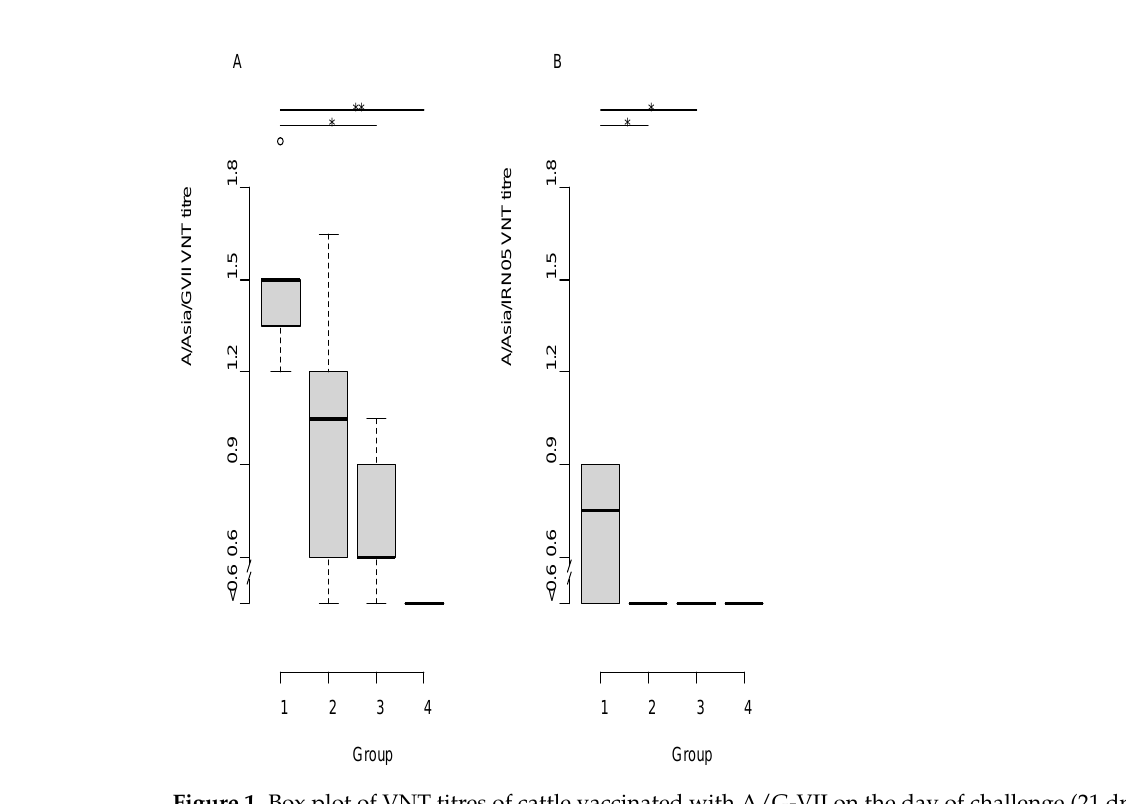
Figure 1. Box plot of VNT titres of cattle vaccinated with A/G-VII on the day of challenge (21 dpv). The horizontal line represents the median titre for each group. In panel ( A ) the VNT titres against A/IRN/22/2015 are shown (representative A/G-VII field isolate); in panel ( B ) the VNT titres against A/IRN/10/2018 are shown. Group 1 = Full dose, 2 = 1/4 dose, 3 = 1/16 dose, 4 = Unvaccinated Control); * = p < 0.05 and ** = p < 0.01. The boxplots show the interquartile range (median represented as the thick horizontal line within the box, and the first and third quartile of the data) and the minimum and maximum values for each group connected to the boxes with the vertical line.